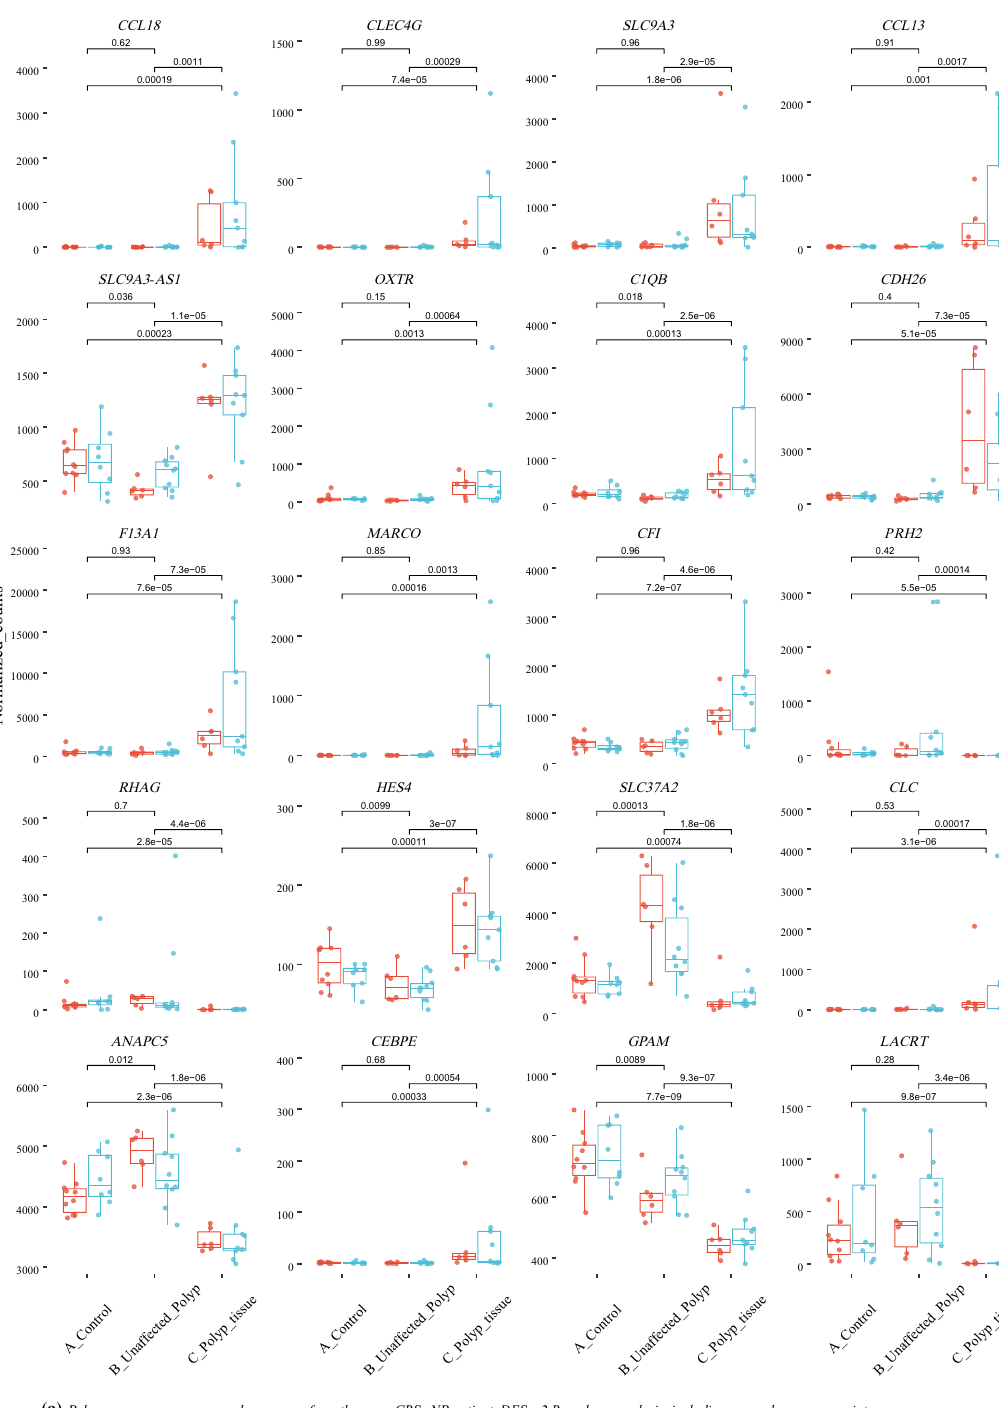
Figure 1. Top 20 differentially expressed genes (DEGs) between non-polyp CRSwNP patient and control patient. ( a ) Polyp mucosa versus non-polyp (unaffected) mucosa from the same CRSwNP patient and ( b ) Healthy control patient mucosa versus non-polyp (unaffected) mucosa from CRSwNP patient. p -values are unadjusted and shown for the comparisons between non-polyp mucosa versus polyp mucosa and control patient mucosa. DESeq2 R package analysis, including sex and age as